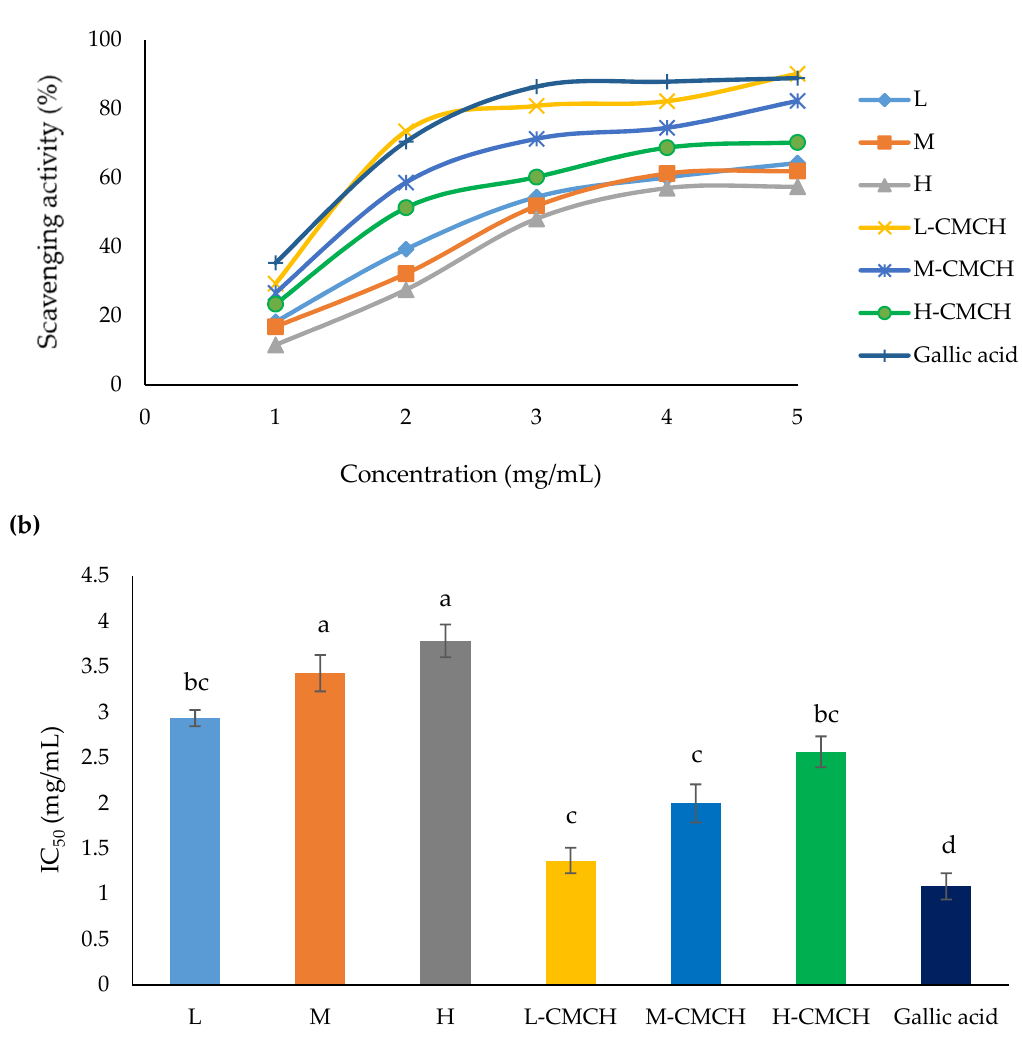
Figure 3. ( a ) ABTS radical scavenging activity (%) and ( b ) IC 50 of L, M, H, L-CMCH, M-CMCH and H-CMCH. Different letters (a-d) indicate significant difference between treatments (p ≤ 0.05).